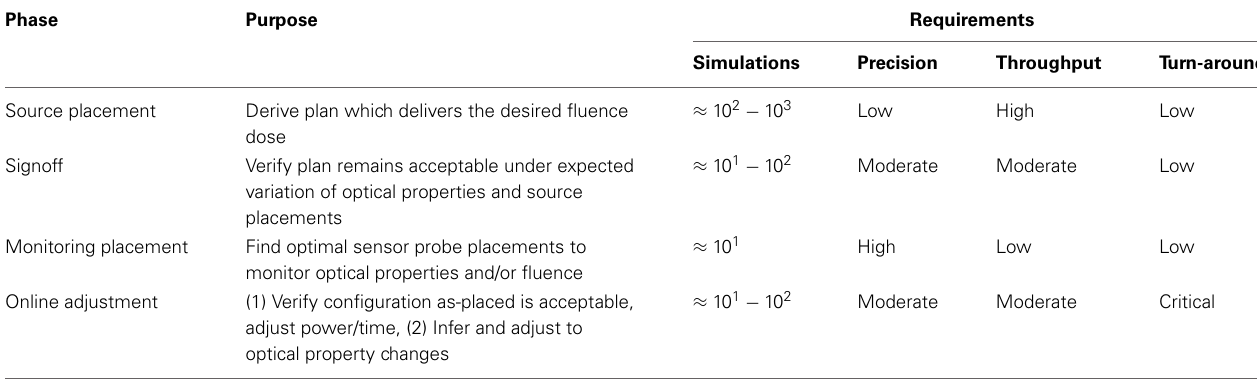
Table 2 | Workflow phases requiring optical